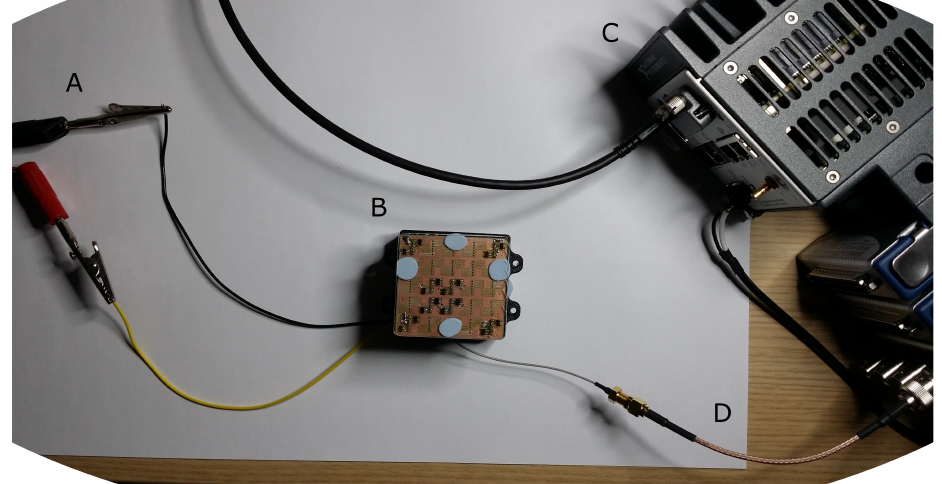
Figure 2. Experimental Setup. ( A ) Power from external supply 5 V. ( B ) Sensors and encoding architecture. ( C ) Compact Rio 9045 used to acquire and demodulate the mixed FM signal. ( D ) Single wire connection to transfer the 8 sensors